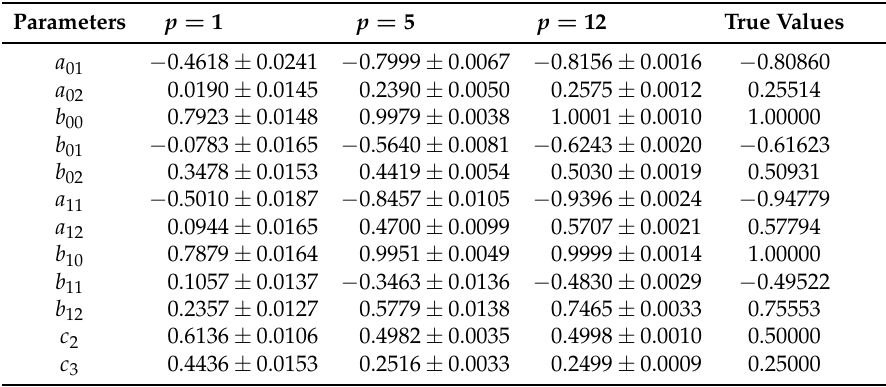
Table 4. The AM-MISG parameter estimates with standard deviations ( σ 2 = 0.10 2